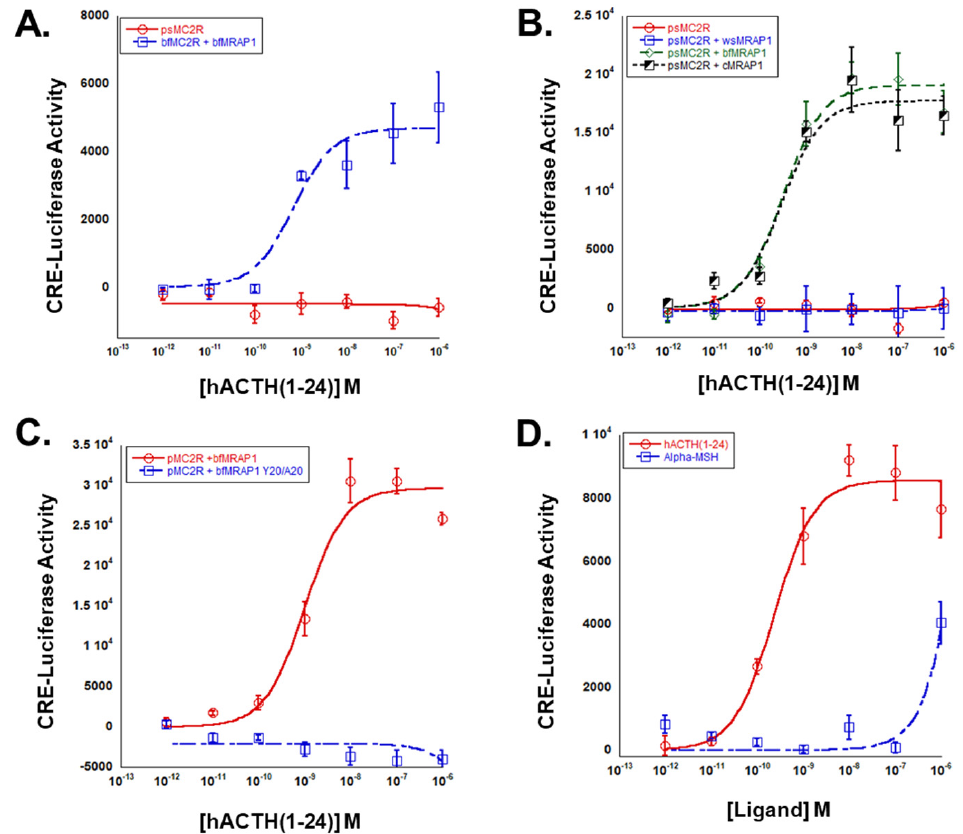
Figure 4. Functional analysis of the paddlefish Mc2r. ( A ) When pMc2r was expressed alone, there was no activation of the receptor by hACTH(1-24). The positive control for this assay was bowfin (bf) Mc2r co-expressed with bfMrap1. Note the robust activation following stimulation with hACTH(1 − 24). ( B ) Analysis of pMc2r stimulation by hACTH(1-24) when co-expressed with various vertebrate Mrap1s: whale shark (ws) Mrap1, bfMrap1, or chicken (c) MRAP1. ( C ) Analysis of pMc2r stimulation by hACTH(1-24) when co-expressed with either bfMrap1 (positive control) or a bfMrap1-Y 20 /A 20 mutant. ( D ) Analysis of ligand selectivity of pMc2r, wherein pMc2r was co-expressed with bfMrap1 and stimulated with either hACTH(1-24) or α -MSH. Data presented as mean ± SEM ( n = 3).